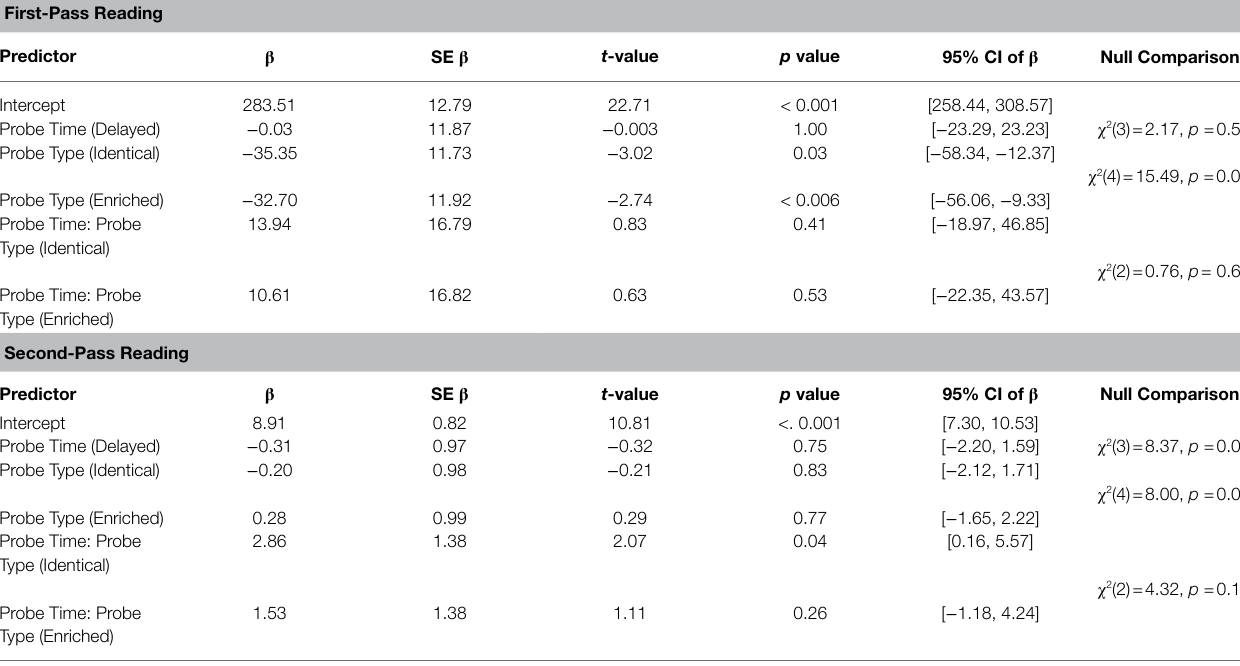
TABLE 2 | Linear regressions for first-and second-pass reading times at the position of the noun phrase complement. First-Pass Reading